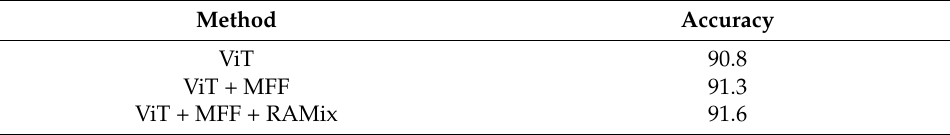
Table 6. Overall ablation